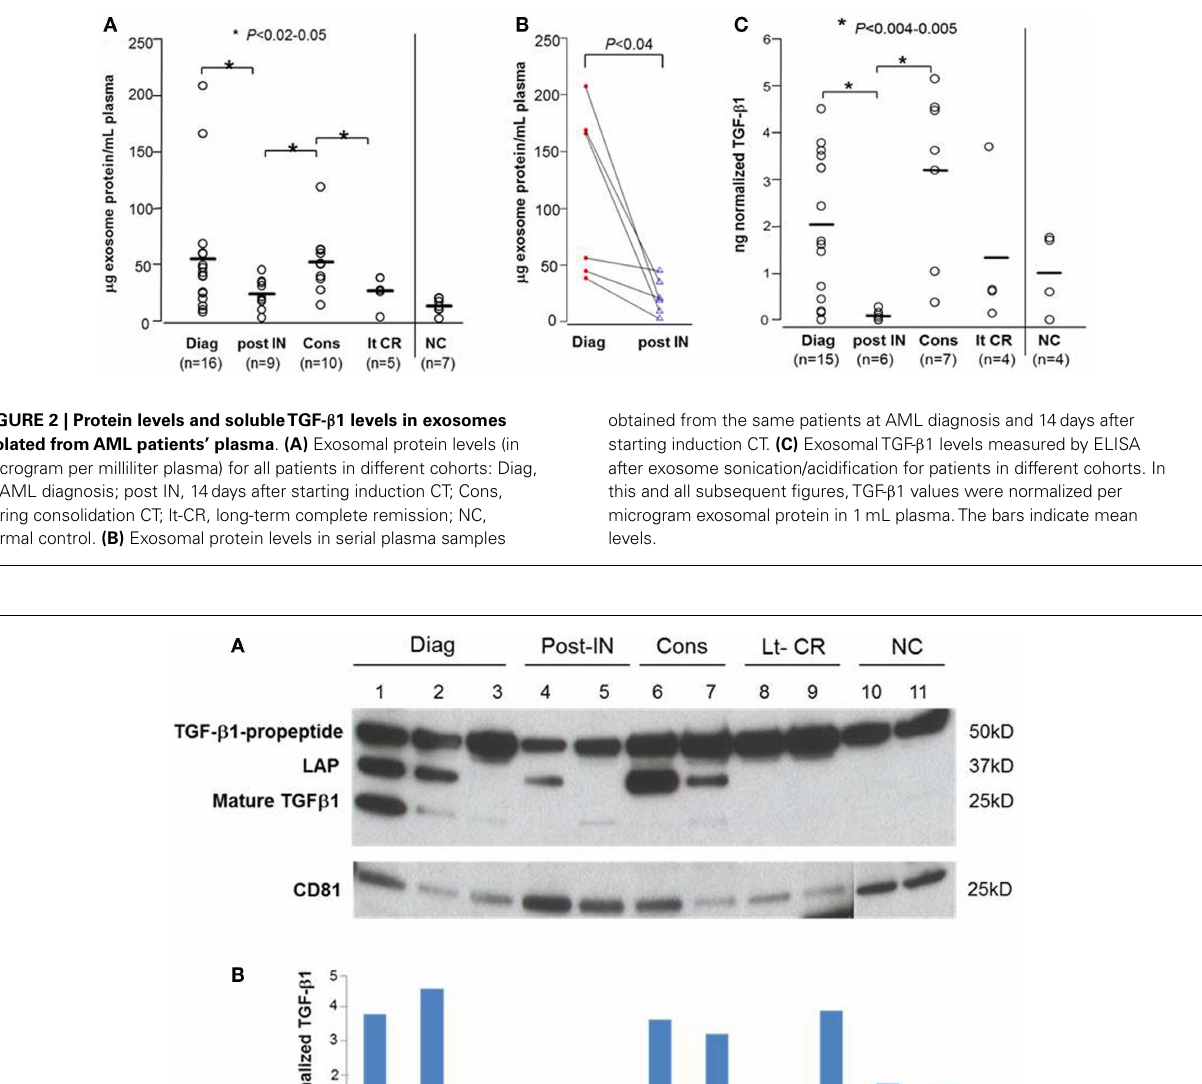
exosomal proteins were separated on SDS/PAGE gel and analyzed by western blots using anti-TGF β 1 and anti-CD81 antibodies. (B) ActiveTGF β 1 levels in the corresponding exosomes following their sonication/acidification. Results are from ELISA performed as described in the Section “Materials and